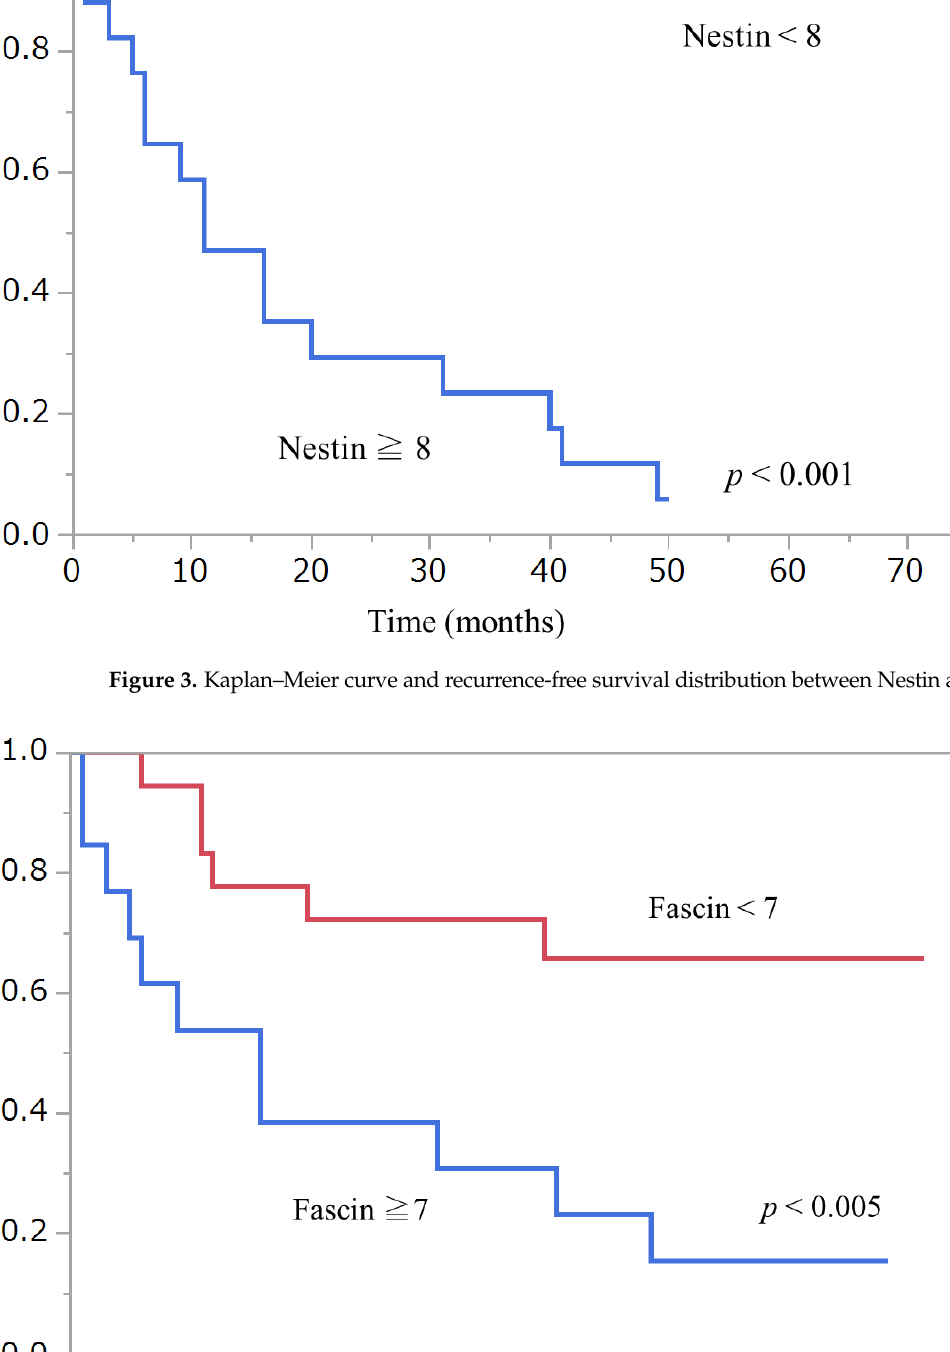
Figure 2. Kaplan – Meier curve and recurrence-free survival distribution between age and metasta- sis.